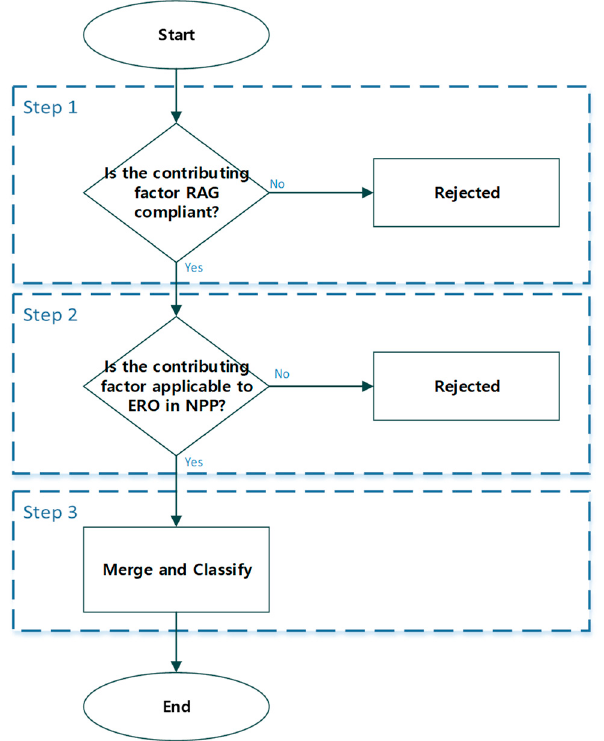
Figure 1. Classification process to identify contributing factors to nuclear power plant (NPP) emer- gency response organization (ERO) resilience.